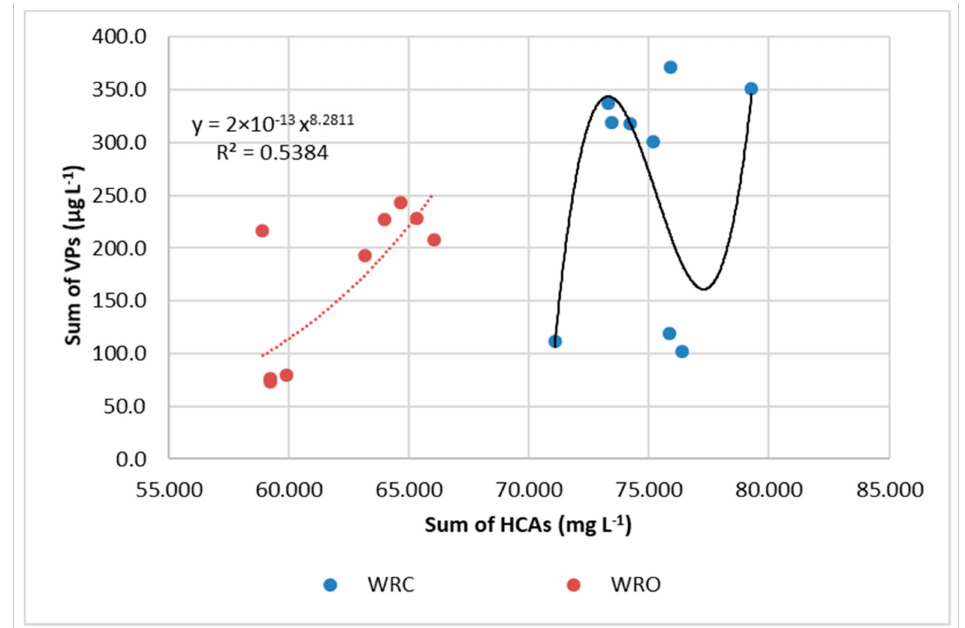
Figure 4. Correlation between the content of the volatile phenolics (VPs) in the Welschriesling experimental variants and the sum of the hydroxycinnamic acids (HCAs), vintages 2015–2017.